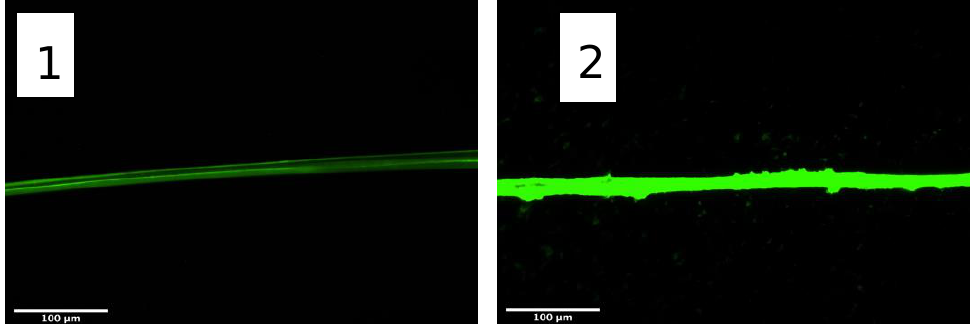
Figure 2. Fluorescence micrographs of SFS regenerated fibers obtained at λ = 520 nm ( 1 ) control (non-biotinylated fiber) incubated with streptavidin-FTIC. ( 2 ) Biotin-functionalized SFS fiber incubated with streptavidin-FITC. Table 2. Quantitative comparison of the fluorescence intensity of the control and biotinylated SFS fibers after being incubated with streptavidin-FITC. Two micrographs were taken from different regions of the fiber and, at least, three measurements of fluorescence intensity were obtained from each micrograph. Values are expressed as mean ± standard error.